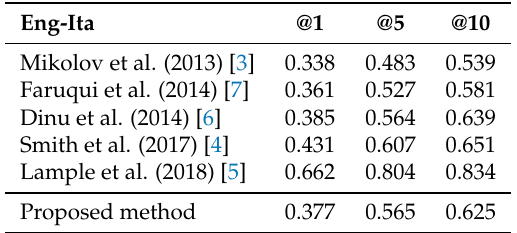
Table 14. Comparing English–Italian results on Dinu’s data.